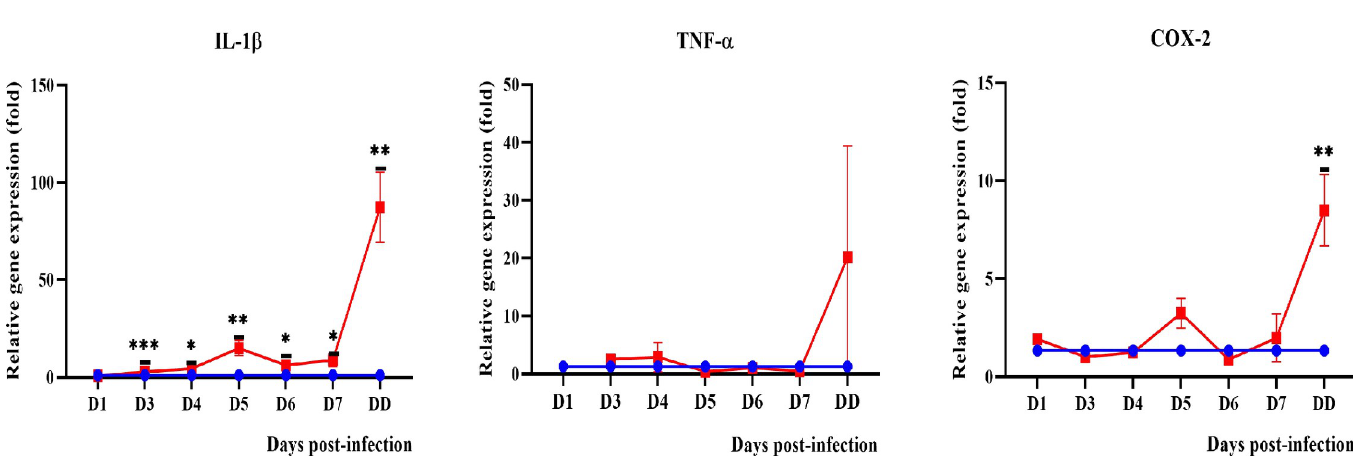
Fig 11. Modulation of pro-inflammatory cytokines and enzymes in the liver of control (blue line) and infected hamsters (red line). Total RNA was extracted from liver on day 1 p.i. and days 3 to 7 p.i. D1-D7: Day 1 to day 7. DD: dead. � P � 0.05, �� P � 0.01, ��� P � 0.001.The fold gene expression value can be found in S2 Table.